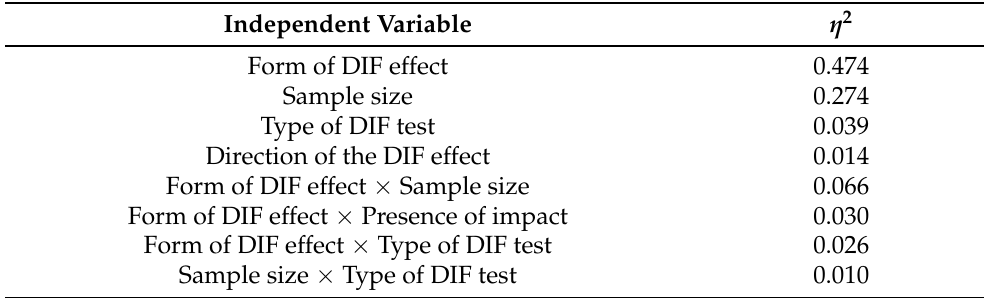
Table 2. All simulation conditions and two-way interactions of simulation conditions with an effect corresponding to an η 2 larger than or equal to 0.01 on the power of the DIF tests.